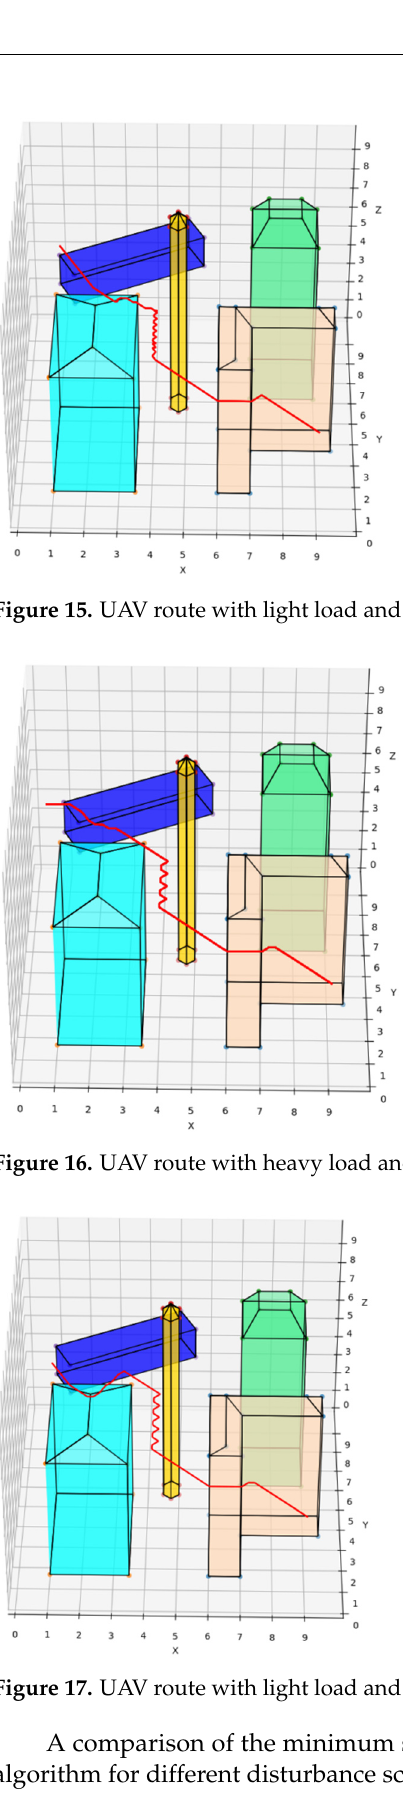
Table 4. Comparison of minimum safe distance under different disturbance scenarios.